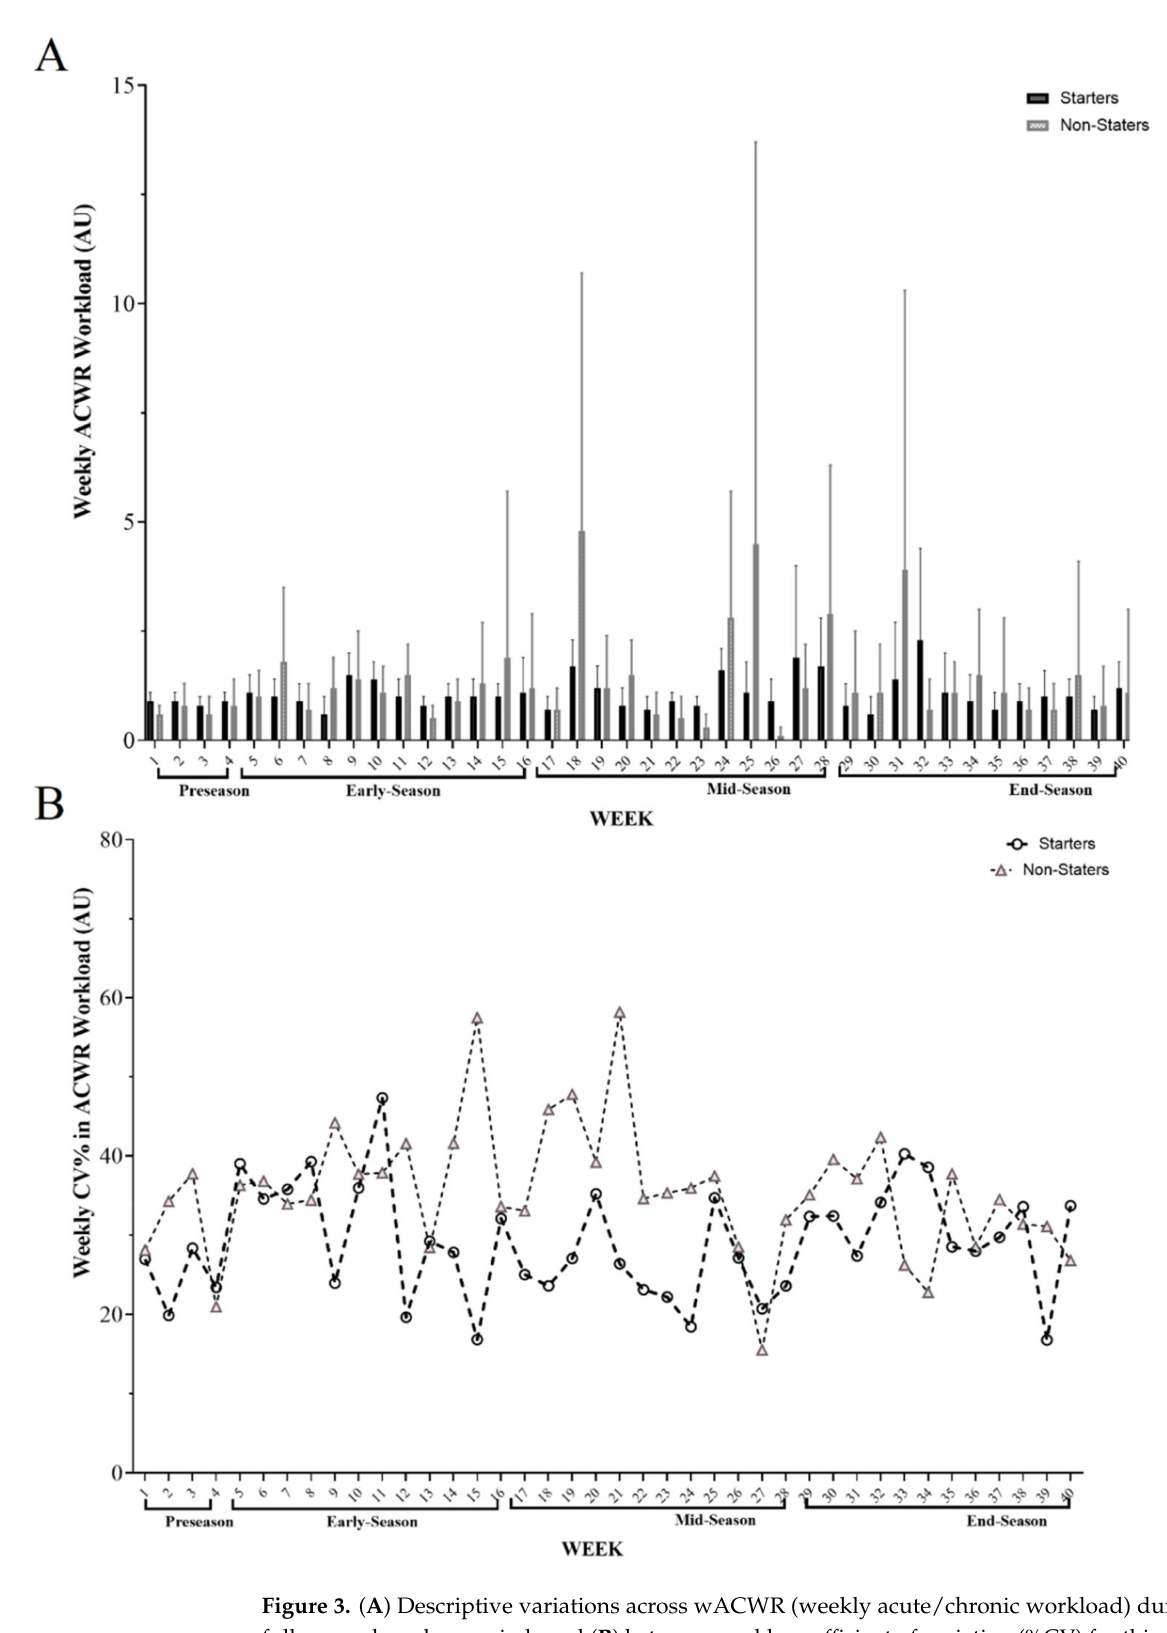
Figure 3. ( A ) Descriptive variations across wACWR (weekly acute/chronic workload) during the full season based on periods and ( B ) between weekly coefficient of variation (%CV) for this variable based on